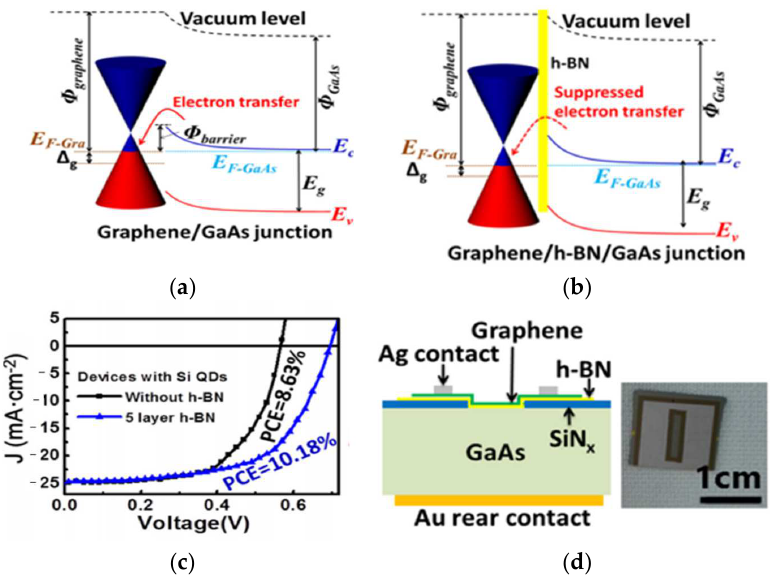
Figure 5. ( a ) Band structure of graphene/GaAs heterojunction. ( b ) Band structure of graphene/h-BN/GaAs heterojunction. ( c ) J–V curves of solar cells based on graphene/GaAs and graphene/h-BN/GaAs heterostructure with Si QDs introduced using photo-induced doping. ( d ) Left: schematic structure of the graphene/h-BN/GaAs sandwich device; right: digital photograph of one typical device [46].